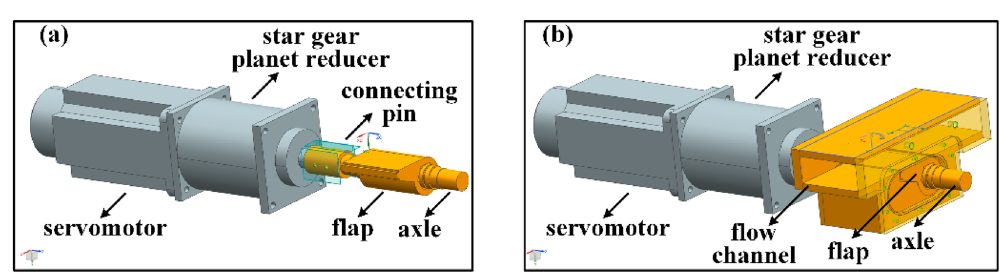
Figure 2. ( a ) The flap with its driven servomotor and ( b ) the flap installed in the flow